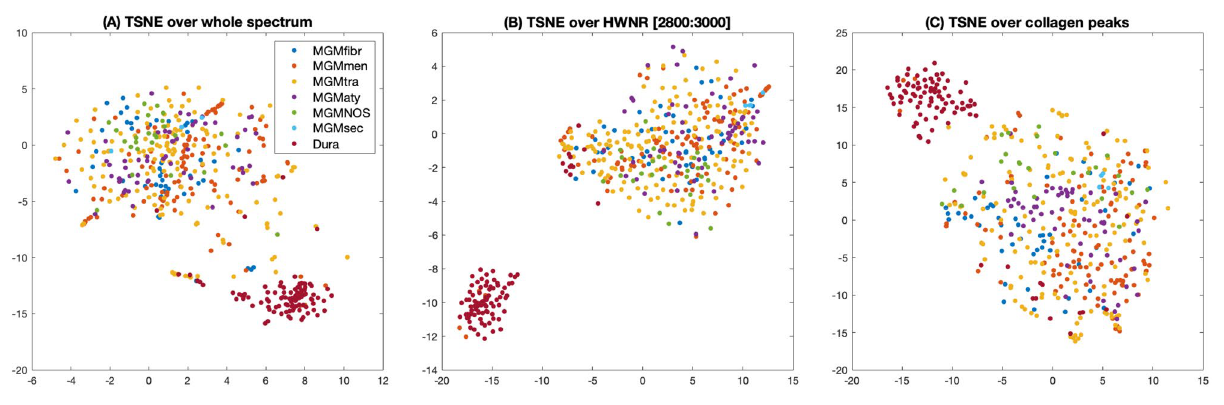
Figure 3. The tSNE-Cluster, based on the training data set, of meningioma subtypes and dura mater. The color- code is the same as in Fig. 2. (A) , tSNE-Cluster of pathologically secured diagnoses of entire Raman spectrum of the chosen subclasses. (B) tSNE Cluster of pathologically approved diagnoses over high-wavenumber region (HWNR), interval 2800 cm −1 to 3000 cm −1 . (C) tSNE Clusters based on collagen